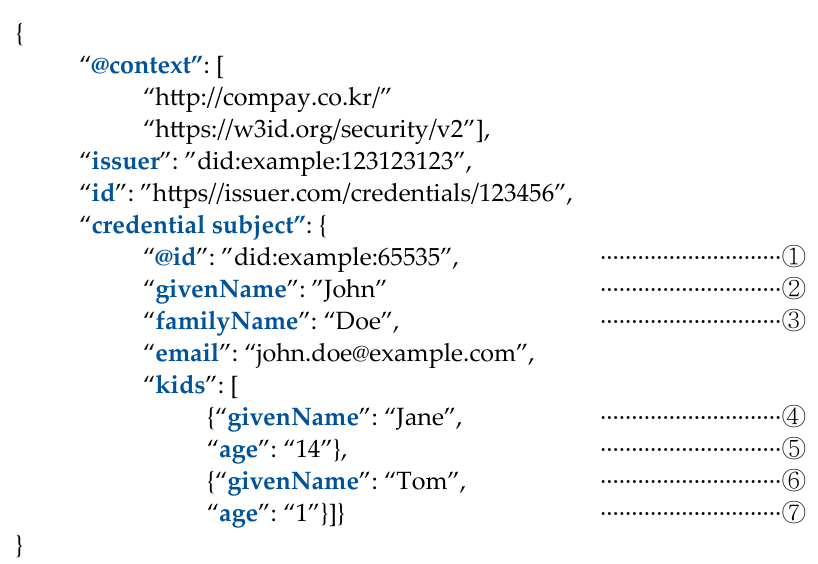
Figure 2. An example of a VC using the JSON-LD data format.